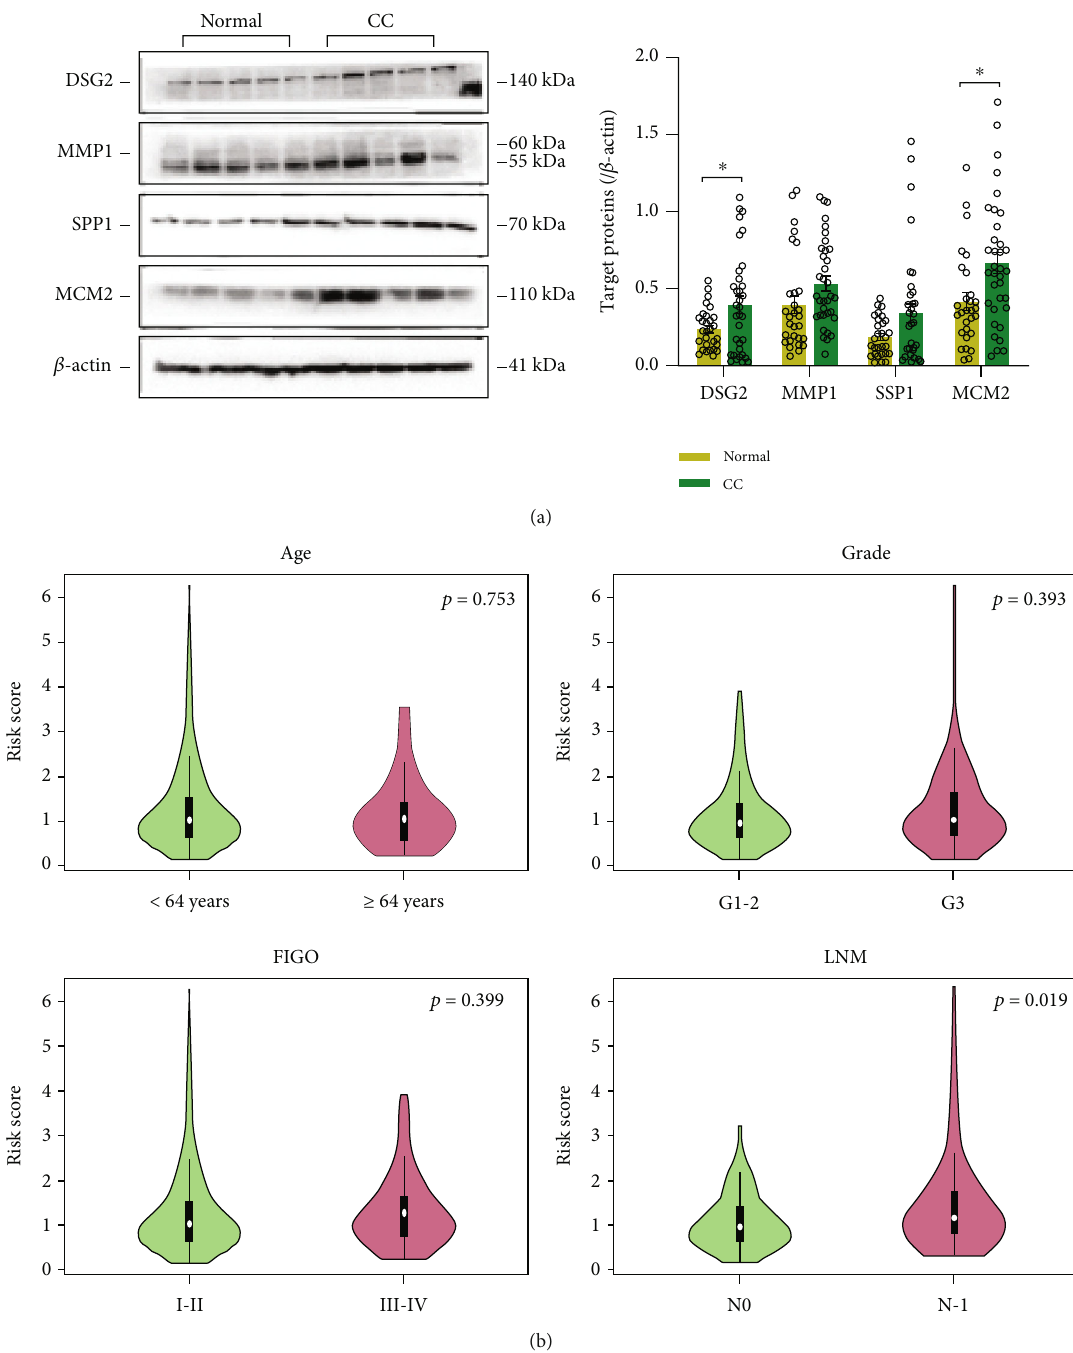
Figure 6: Western blotting and clinical analyses. (a) Immunoblots for four-gene prognostic signature associated proteins DSG2 (CC n = 34 , normal n = 29 ), MMP1 (CC n = 35 , normal n = 29 ), SPP1 (CC n = 36 , normal n = 30 ), MCM2 (CC n = 35 , normal n = 29 ), and quantitative data. ∗ p < 0 : 05 vs. normal. (b) Violin plots showing di ff erences in the mean risk score in CC patients strati fi ed by age ( mean ± SEM